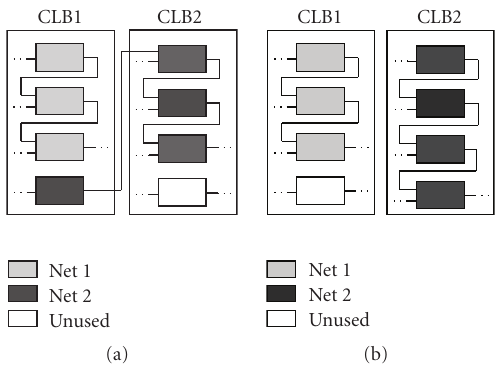
Figure 3: Impact of unrelated block clustering, Net 1 followed by Net 2. (a) introduces an inter-CLB delay and an external connection between CLB1 and CLB2. (b) no inter-CLB delay, no external connection, and less routing resource demand when CLB1 is under-